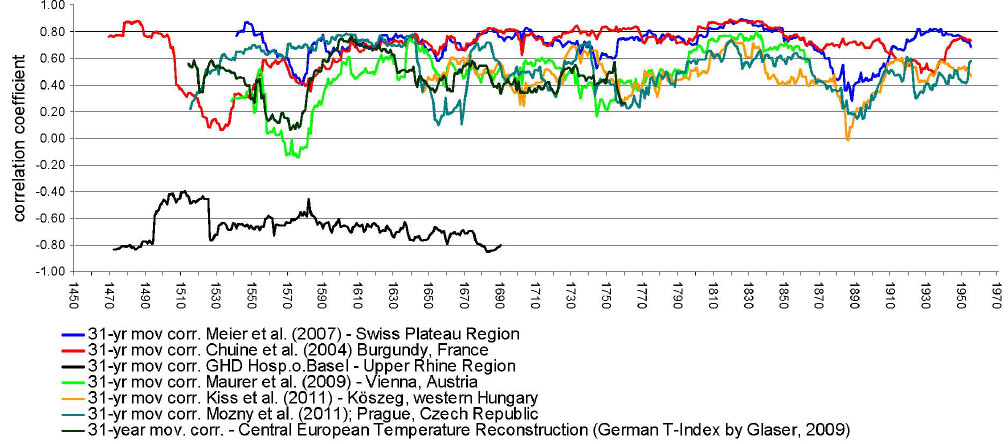
Fig. 10. 31-yr moving correlations between Basel WGHD- and other European temperature reconstructions Swiss temperature reconstruction by Meier et al. (2007) French temperature reconstruction by Chuine et al. (2004) Austrian temperature reconstruction by Maurer et al. (2009) Hungarian temperature reconstruction by Kiss et al. (2011) Czech Republic temperature reconstruction by Mozny et al. (2011) German temperature reconstruction (T-Index by Glaser) in Dobrovoln´y et al. (2009). Table 4. Overall correlations between Basel WGHD temper- ature anomalies reconstruction and temperature reconstructions from Switzerland, Germany, Austria, France, Hungary and Czech